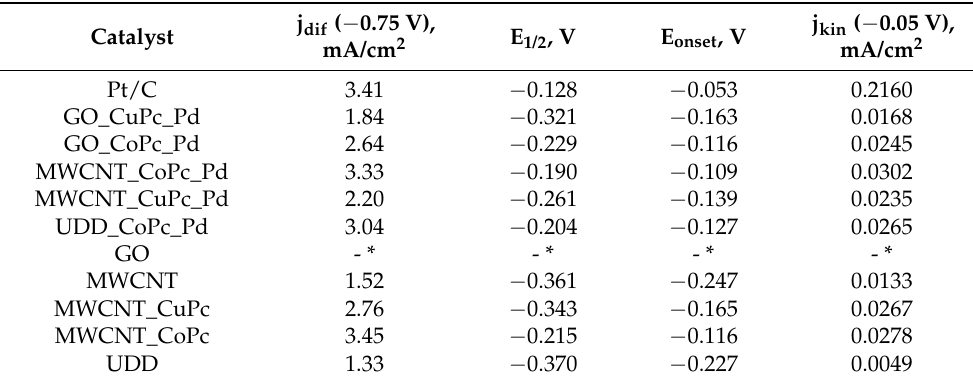
j kin ( − 0.05 V), mA/cm 2